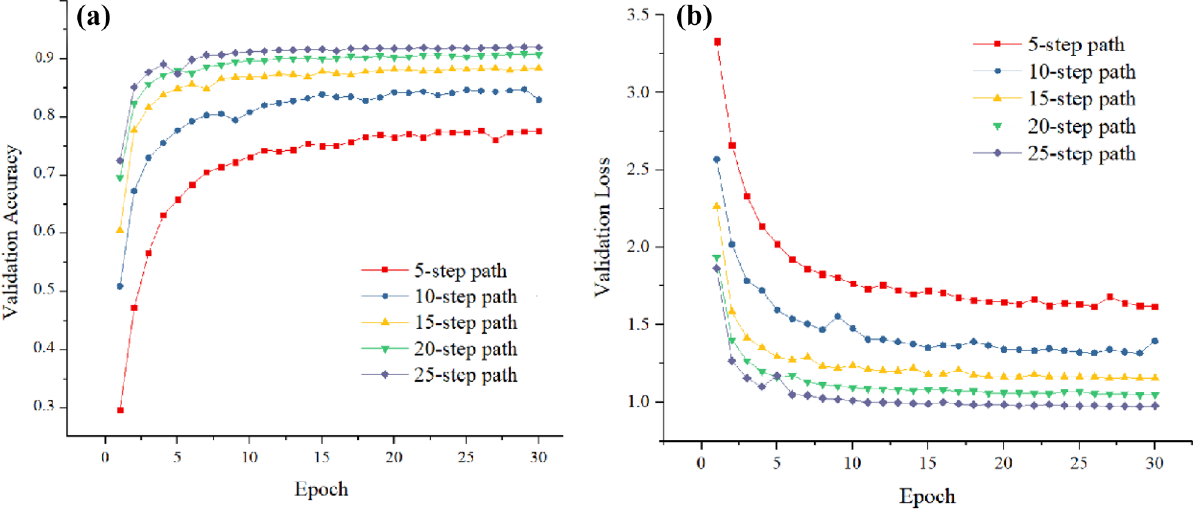
Figure 6. ( a ) Validation Accuracy and ( b ) Validation Loss versus Epoch for different step